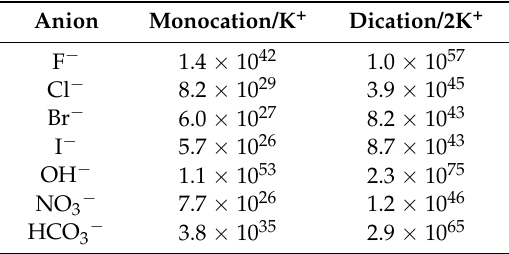
Table 7. Preference of anions for tetrel-bonding species over one or two K +